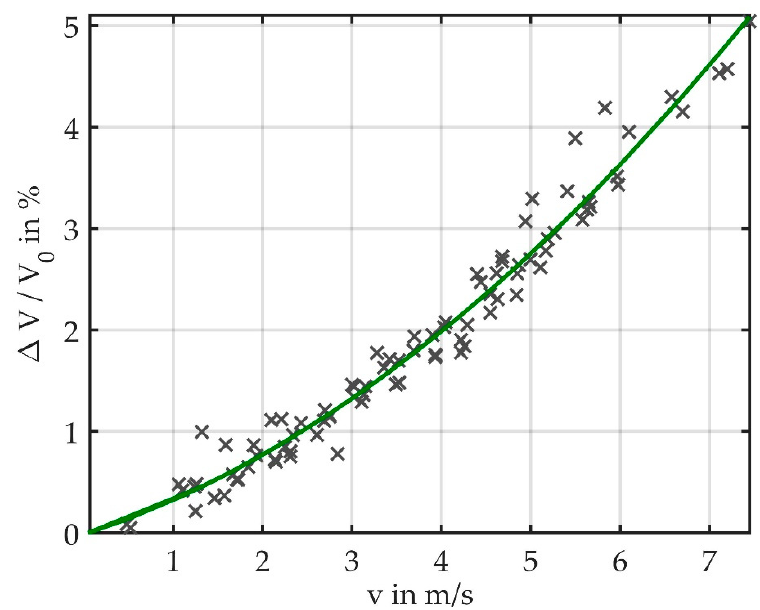
Figure 8. Measurement results showing that the light loss depends quadratically on the flow velocity. Results of three measurements with flow velocities from 0.48 m/s to 7.5 m/s are marked as well as the quadratic fit.